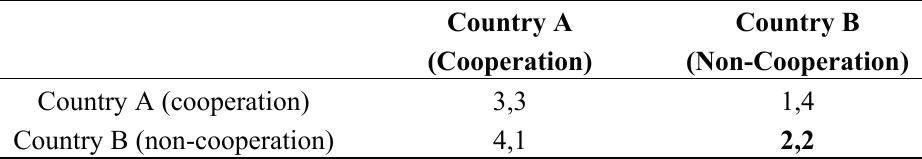
Table 1. Dilemmas of common competitive